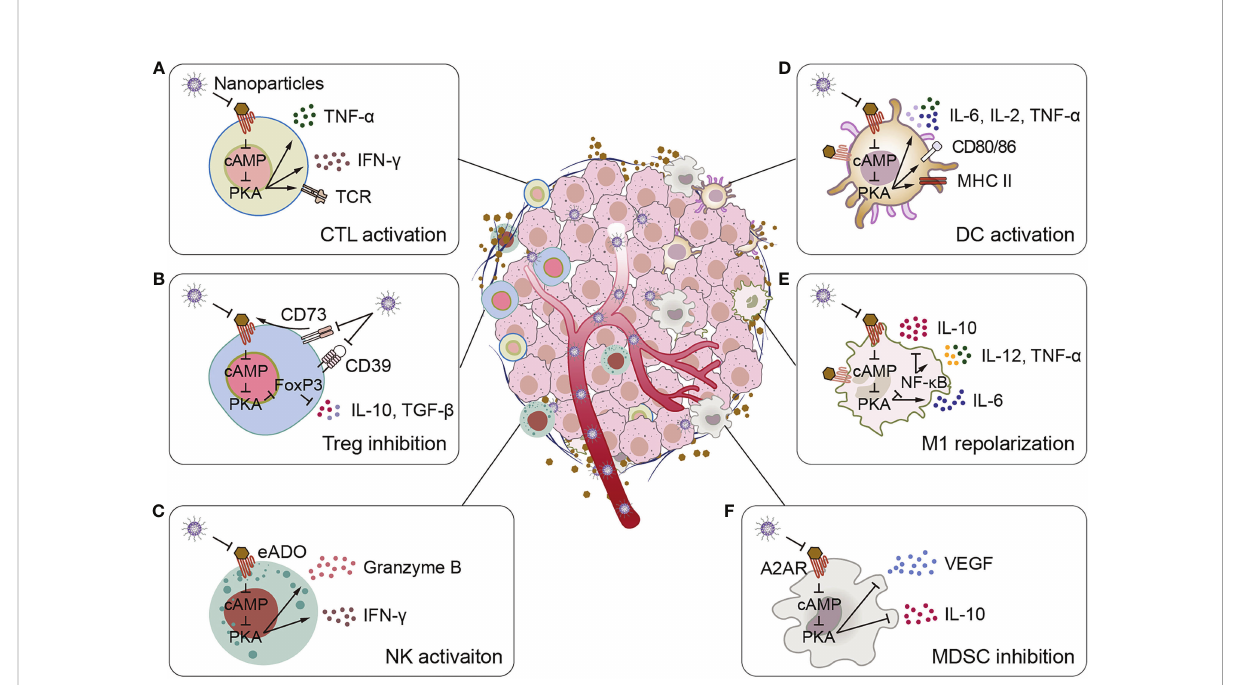
FIGURE 1 Schematicillustrationofadenosine-mediatedimmunosuppressiveTMEsreversedbybiomaterials. (A) Biomaterialsactivate CTLs, promote CTLstoexpress TCRand secrete pro-in fl ammatorycytokinesIFN- g and TNF- a . (B) Biomaterialsinhibitadenosineproductionandadenosinebindingtoreceptors,thereby inhibitingIL-10 andTGF- b secretionby Tregs. (C) BiomaterialsactivateNKcellstopromotethesecretionof granzymeBand IFN- g . (D) Biomaterials stimulate theexpressionof surfaceactivationmarkersof DCs(CD80,CD86, andMHCII)andthesecretionof pro-in fl ammatorycytokinesIL-2, IL-6and TNF- a . (E) Biomaterialspromotethe polarizeof macrophagestoM1phenotype, inhibit thesecretionof the anti-in fl ammatorycytokineIL-10,